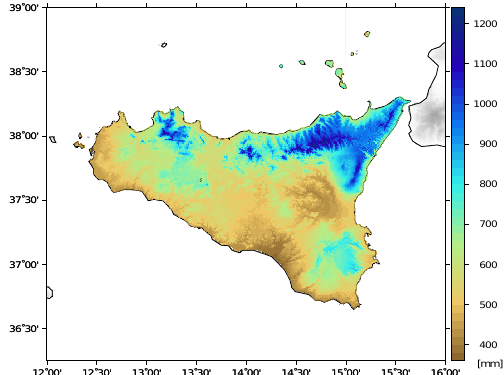
Figure 2. Climatic normals (1961–1990) of annual precipitation to- tals for Sicily at 30arcsec